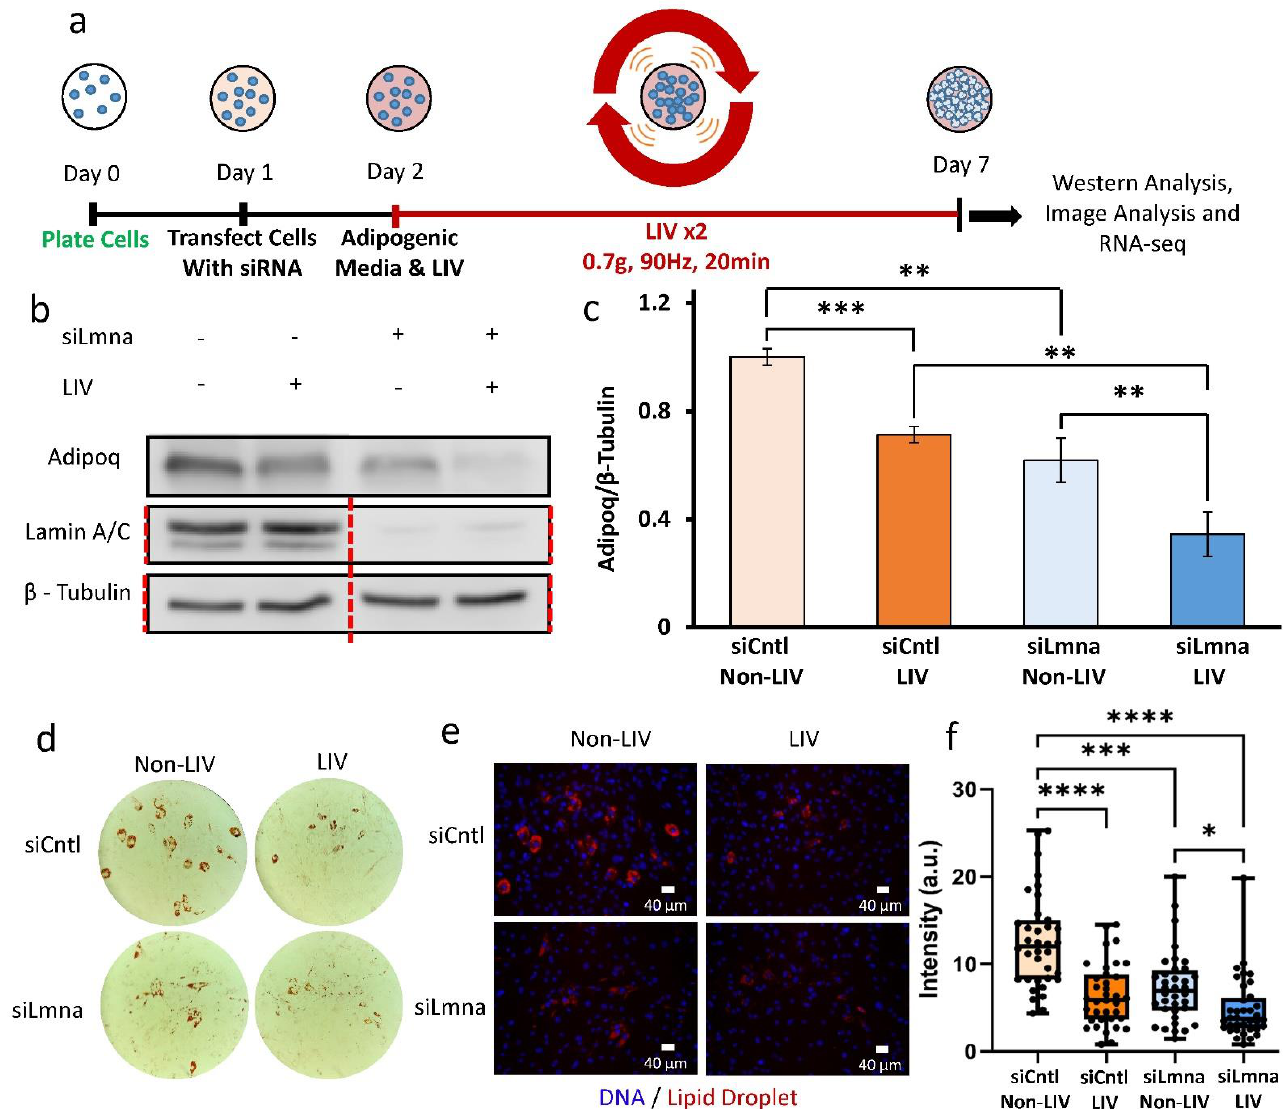
Figure 4. Application of daily LIV treatment decreases adipogenic differentiation in MSCs: a On day 0 cells were plated. Then, on day 1 cells were transfected with siRNA. On day 2 adipogenic media was placed on cells and cells were treated with LIV for 20 minutes, twice daily. Once cells differentiated, cells were pulled off for western analysis, image analysis, and RNA-seq. b Representative western blots of cells treated with siCntl and siLmna after 7 days of adipogenic induction with and without LIV treatment. Adiponectin (Adipoq), lamin A/C, and β -Tubulin were targeted. Lamin A/C and β – Tubulin were imaged on the same plot. Red line represents western blot cropped for alignment; uncropped blots were provided in Figure.S4. c Relative levels of adiponectin of the siCntl and the siLmna groups. Adipoq levels in siLmna treated MSCs with no LIV were decreased by 39% ( p < 0.01, n = 4) compared to siCntl MSCs with no LIV. LIV treated samples had 30% reduction in Adipoq levels compared to non-LIV controls for siCntl treated cells ( p < 0.001, n = 3/grp). siLmna treated cells treated with LIV had a reduction of Adipoq levels of 44% compared to non-LIV samples ( p < 0.01, n = 3/grp). siLmna cells treated with LIV compared to siCntl cells with LIV treatment had a 51% reduction in Adipoq ( p < 0.01, n = 3/grp). d Representative Oil-Red-O images. e Representative images of lipid droplet staining corresponding to Oil-Red-O images Scale bars: 40 μ m. f Analysis of the mean lipid droplet intensity per cell. LIV treated siCntl cells experienced a decrease of lipid droplet mean intensity by 49% ( n = 36, p < 0.0001). siLmna cells treated with